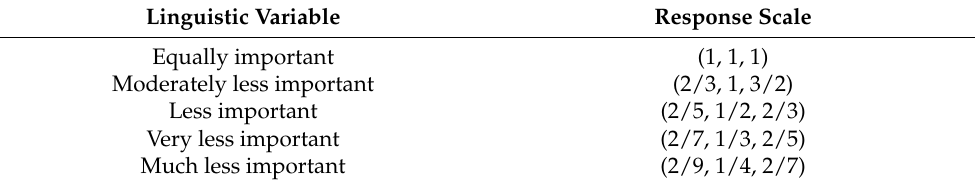
Table 2. The fuzzy comparison scale for the assessment of evaluation criteria [55].